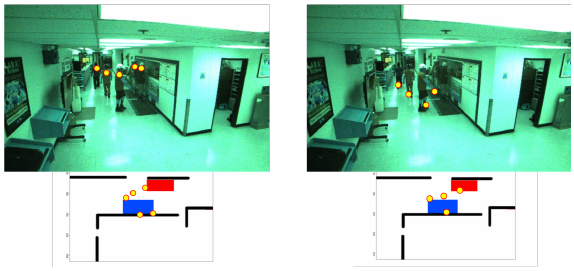
Figure 8. Detections on anthropometric planes: All workers heads are detected (left) while not all ankles are detected (right)